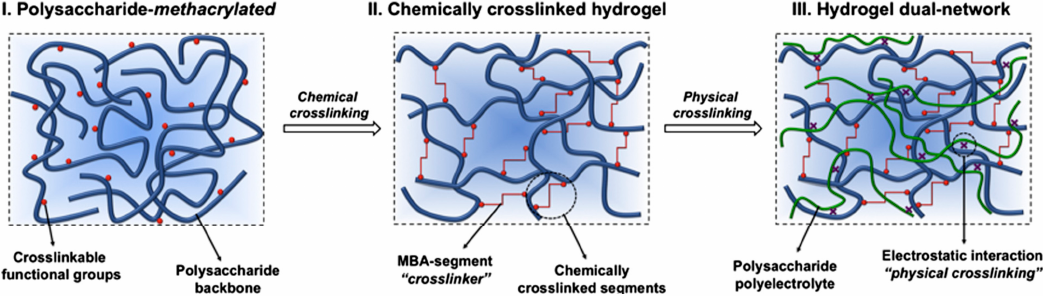
Figure 4. Scheme of dual-network hydrogel formation schematic (Step 1 is the chemical crosslinking; Step 2 is the physical crosslinking). Reproduced with permission from [18].